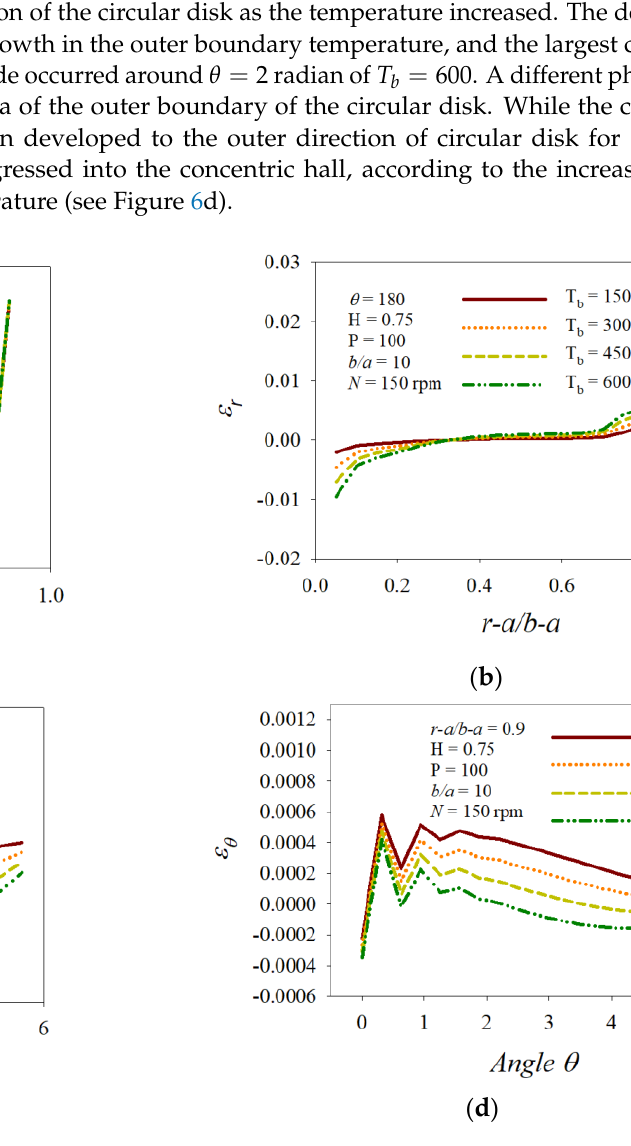
( d ) Figure 5. Effects of outer boundary temperature on the components of stress: ( a ) Radial at θ = 0 , ( b ) radial at θ = 180 , ( c ) circumferential at (r − a)/(b − a) = 0.1, ( d ) circumferential at (r − a)/(b − a) = 0.9.